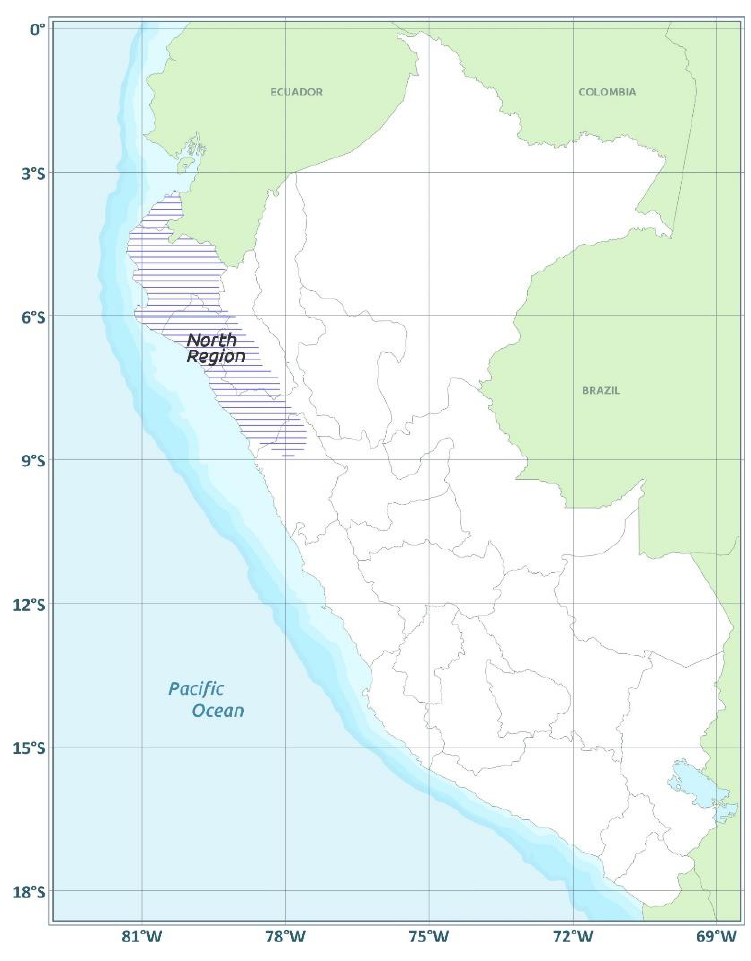
Figure 1. Location of the study area.